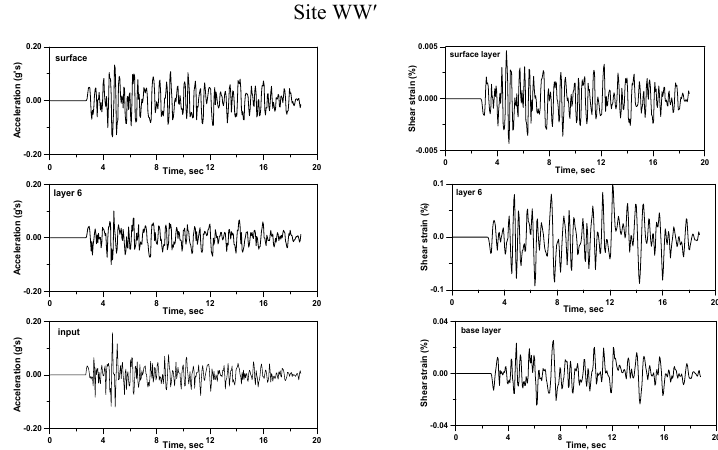
Fig. 27. Acceleration (left column) and strain (right column) time histories at different ground level.